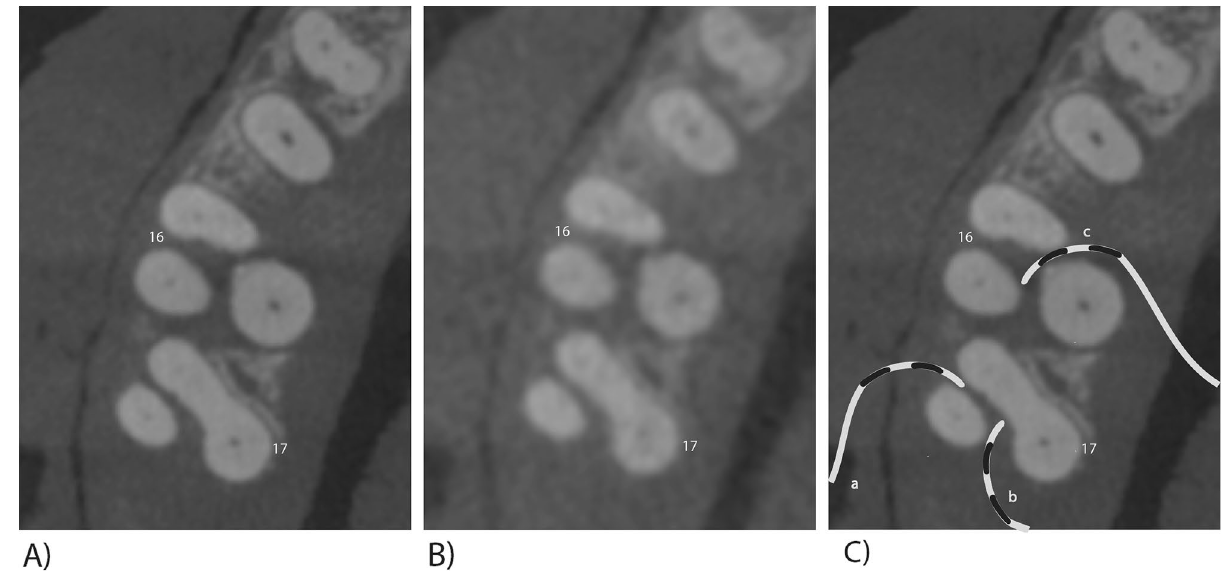
Figure 2. Different CBCT modes of teeth 16 and 17 with furcation defects. ( A ) HD-CBCT ( B ) LD-CBCT ( C ) . a – c : different problematic intrasurgical probing angles leading to underestimation of the furcation